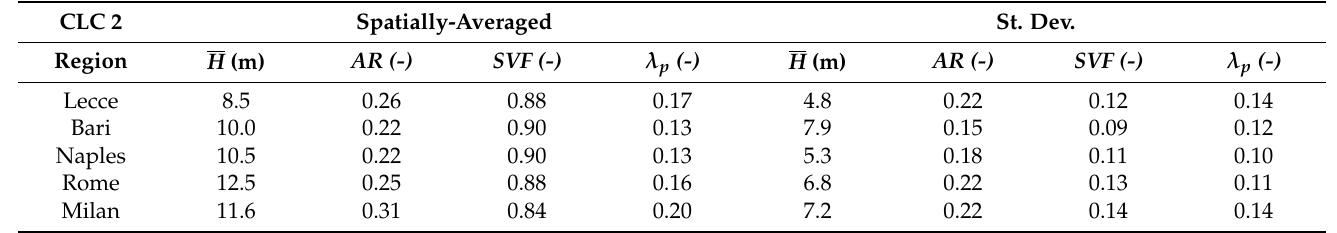
Table 3. Spatially-averaged values and standard deviations of the morphological parameters over the CLC 2 area.